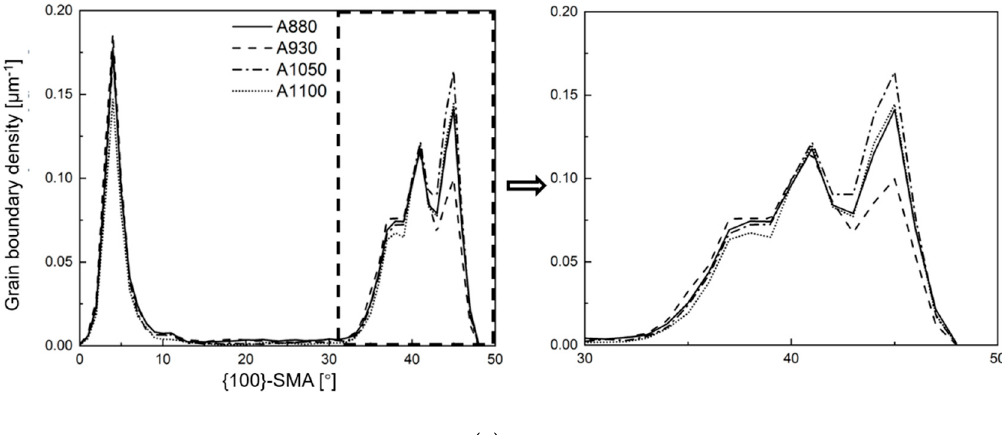
( a ) ( a ) Figure 8. Cont